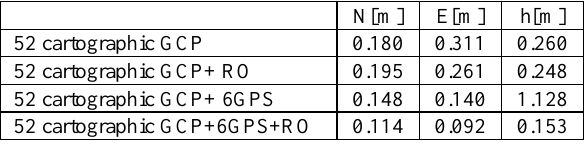
Table 1 - RMSe from the differences between GPS and